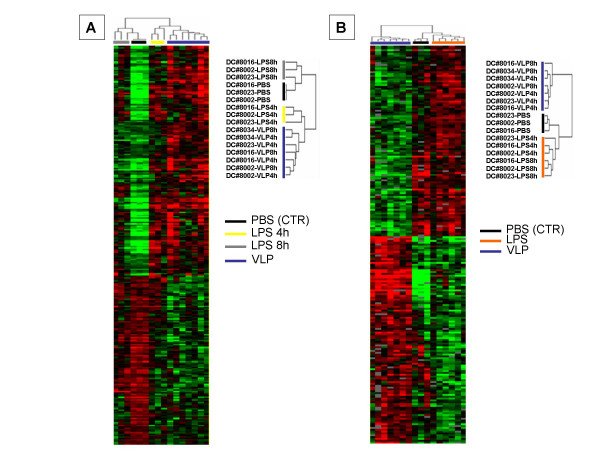
Supervised hierarchical clustering of genes differentially expressed in HIV-VLP-treated MDDCs. The clusterograms represent an Eisen hierarchical clustering of the 281 genes differentially expressed (p < 0.005) in HIV-VLPs-treated MDDCs, compared to PBS treatment (A), and of 217 genes differentially expressed (p < 0.005) in HIV-VLPs-treated MDDCs, compared to LPS treatment (B). The clustering is defined by the dendrogram on the top and on the side of the clusterogram.